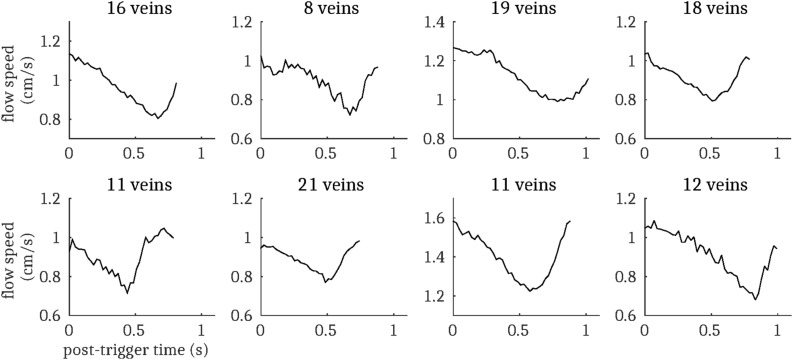
Cardiac cycle synchronized venous blood flow time-courses for each subject (mean across all pulsatile cortical veins; N.B. does not include the venous sinuses). The number of pulsatile veins for each subject is displayed above the respective plot.